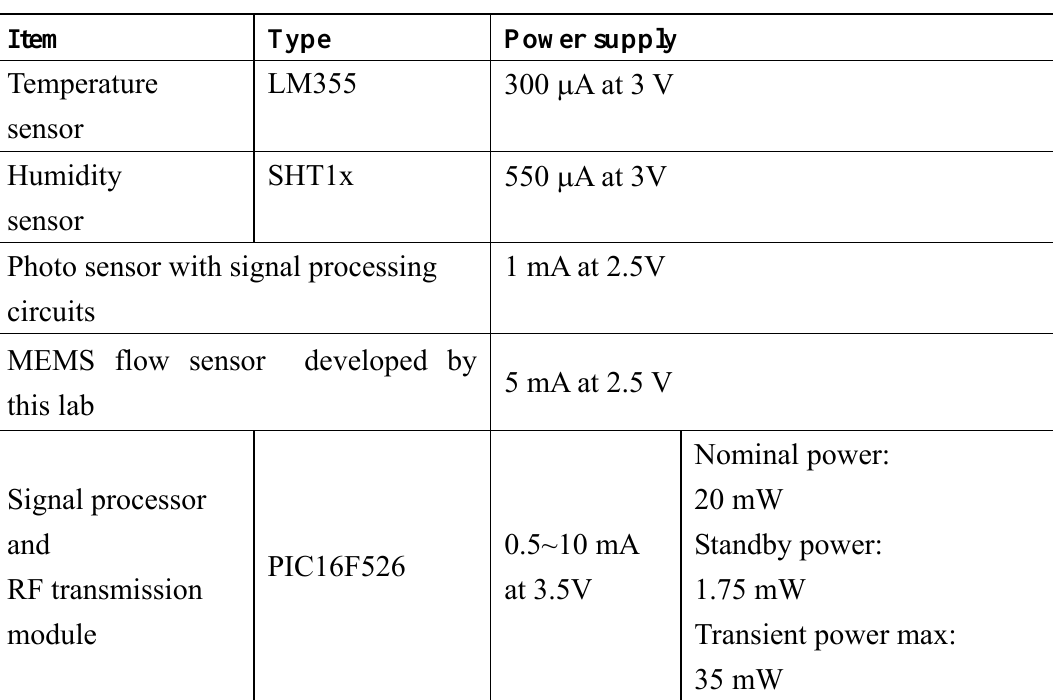
Table 1. The power consumptions of each sensor and component of the wireless sensor node powered by energy